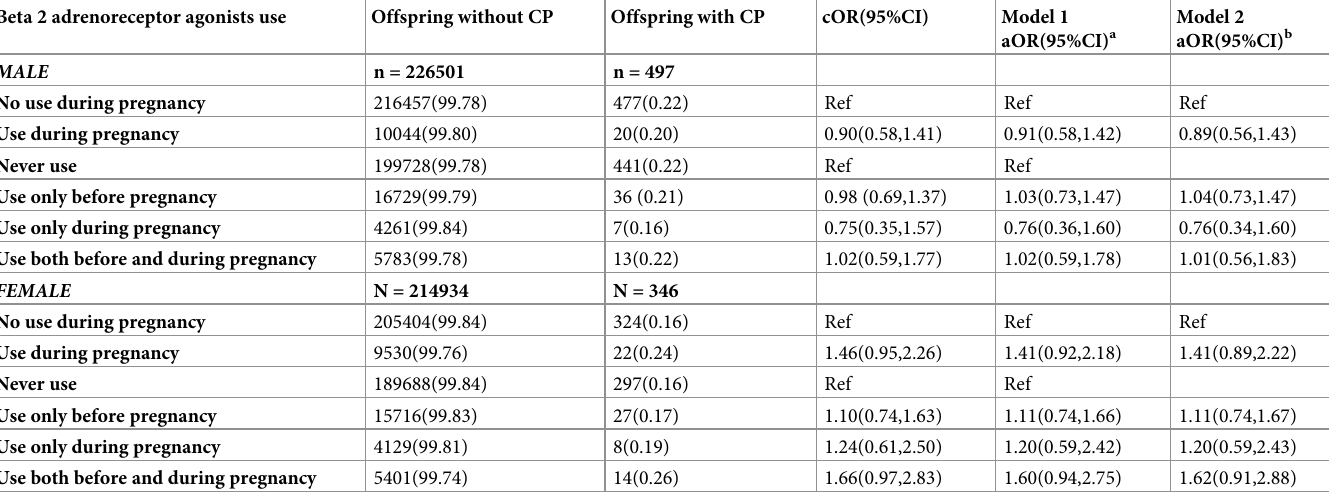
Table 3. Association between maternal β 2AAs usage and cerebral palsy in offspring by gender. Beta 2 adrenoreceptor agonists